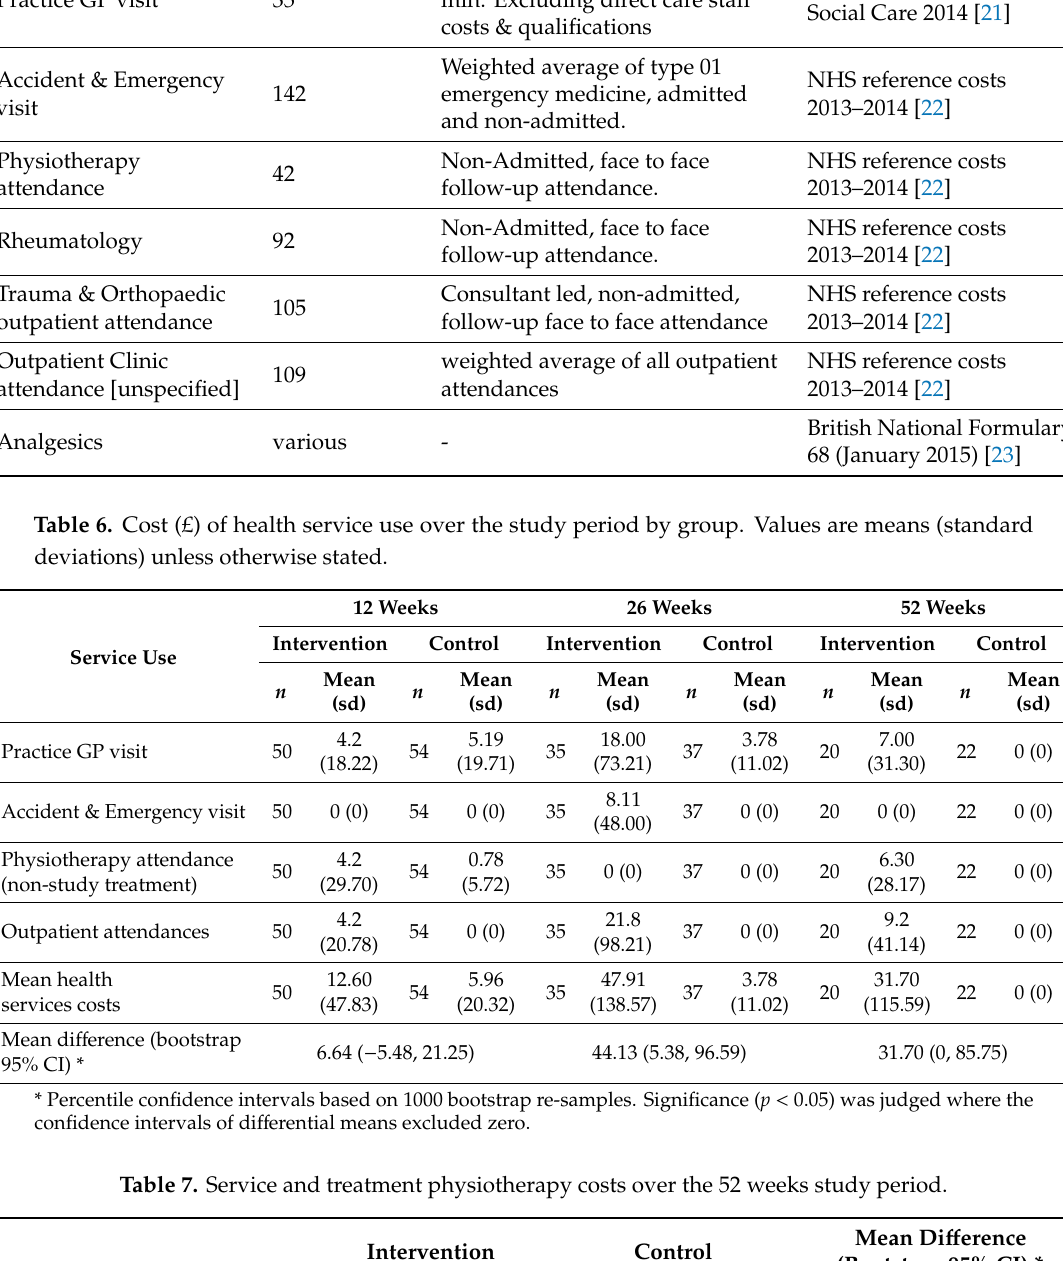
Table 7. Service and treatment physiotherapy costs over the 52 weeks study period.